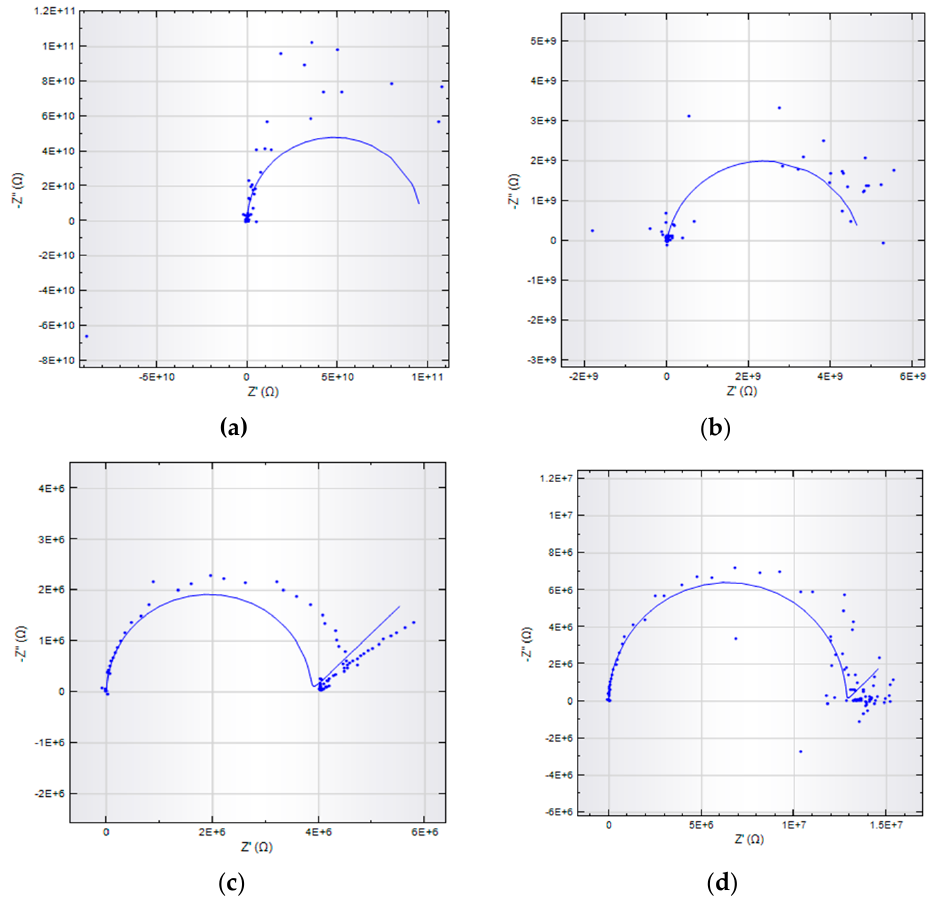
Figure 10. Modeled Nyquist plots for virgin and aged samples ( a ) Reference, ( b ) Experiment 1, ( c ) Experiment 2, ( d ) Experiment 3.